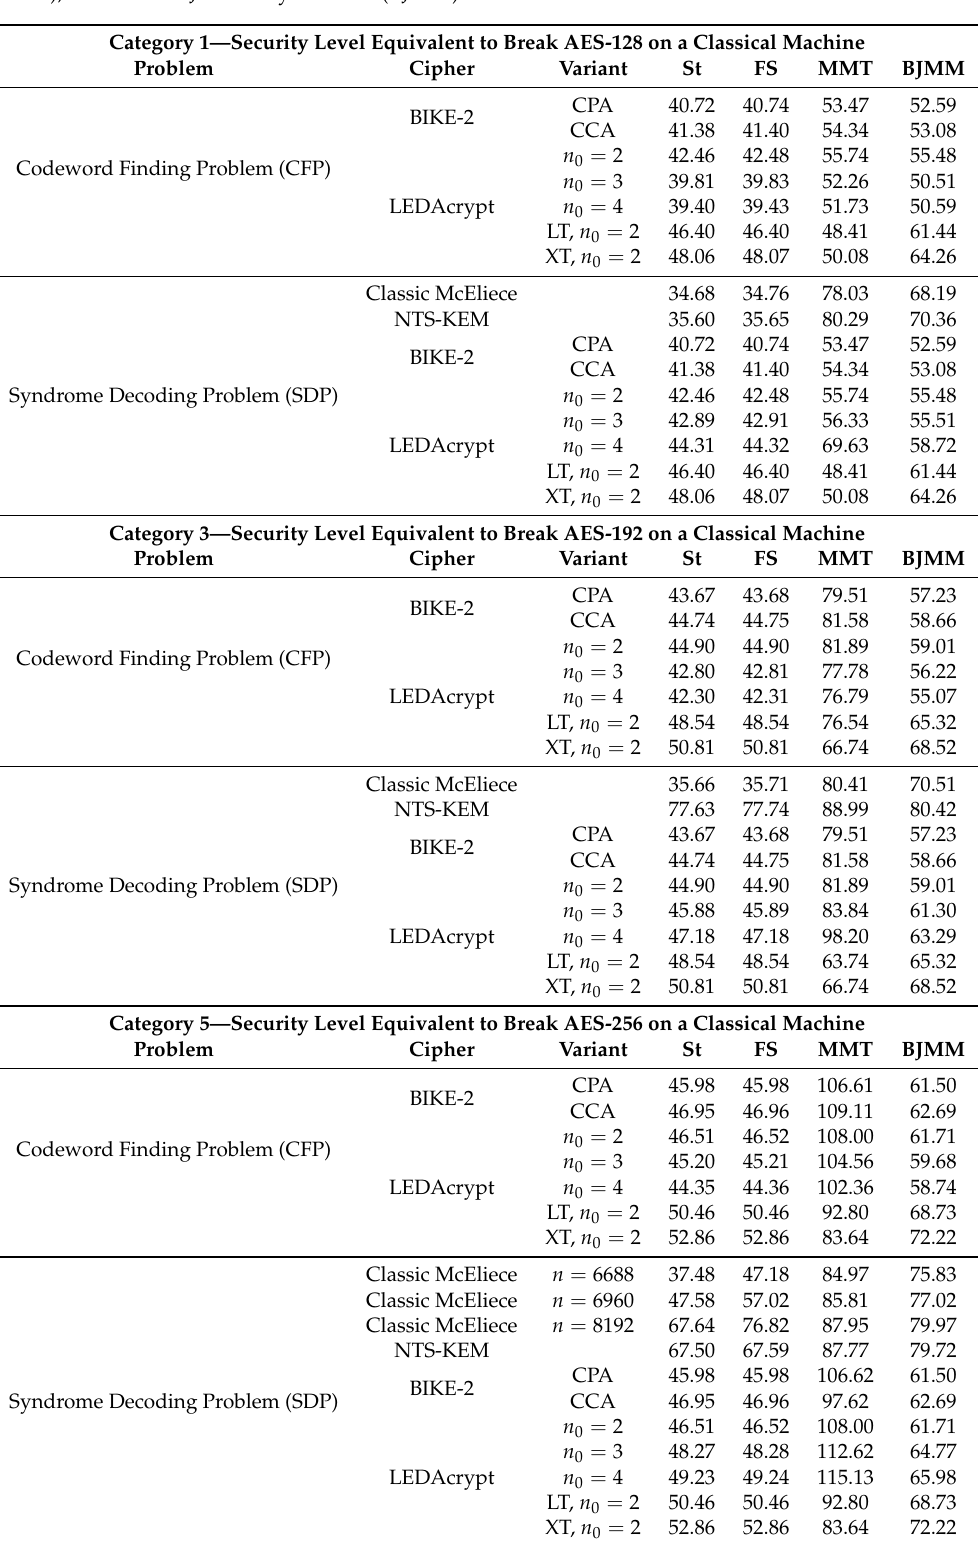
( memory _ size _ in _ bits ) , for each list-based ISDs (i.e., St [13], Table 5. Memory costs expressed as log 2 FS [14], MMT [15], and BJMM [16]) applied to NIST round-2 code-based cryptosystems. Information Set Decoding (ISD) variants are labeled as: Stern (ST), Finiasz and Sendrier (FS), May–Meurer–Thomae (MMT), and Becker–Joux–May–Meurer